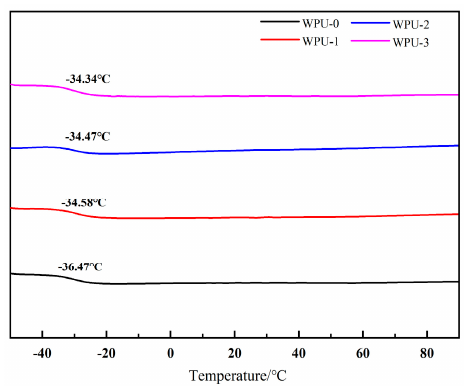
Figure 5. Di ff erential scanning calorimetry (DSC) thermograms of WPU dispersions with di ff erent Figure 5. Differential scanning calorimetry (DSC) thermograms of WPU dispersions with different APTS contents. APTS contents.